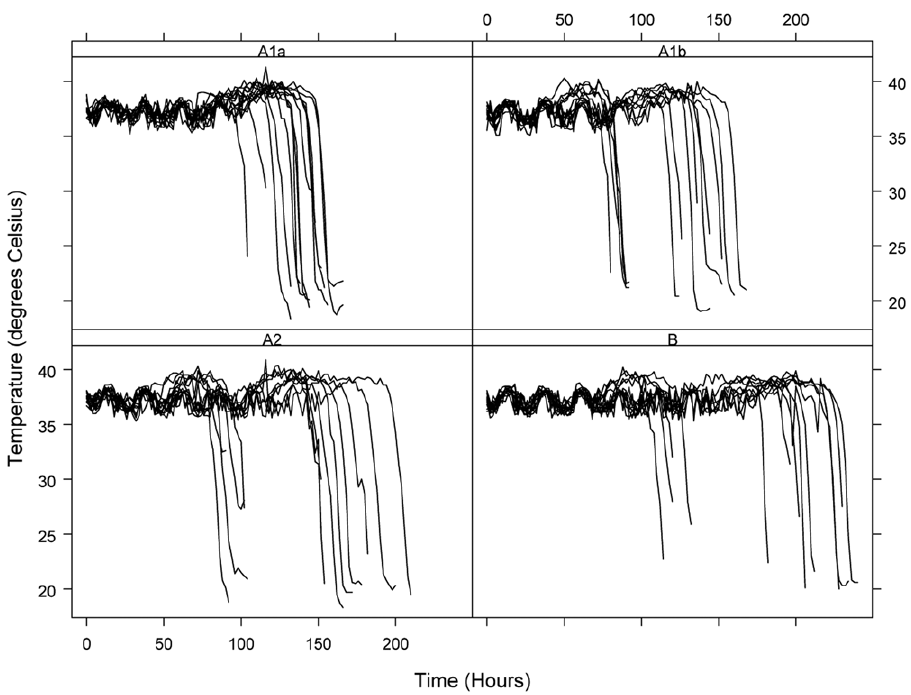
Figure 1. Temperature curves. Mice (n=14 mice for each of the four F. tularensis infection groups) infected in round 1 and round 2 with F. tularensis groups (A1a, A1b, A2 and type B) are shown. Mice were infected with F. tularensis and temperature was monitored every 1–2 hours until